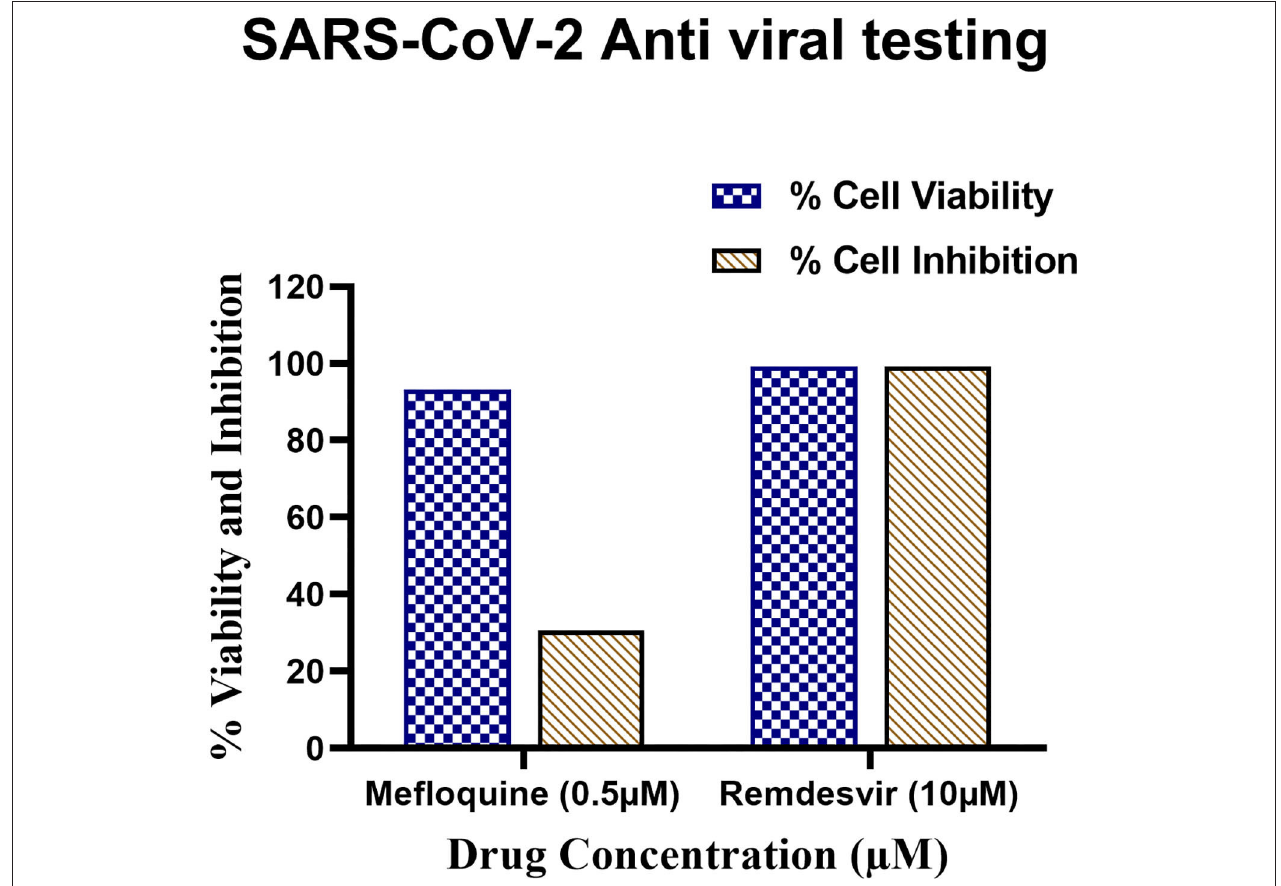
FIGURE 10 | Antiviral testing of Mefloquine against SARS-CoV-2 in VeroE6 cells. (i) The ∼ 10 4 VeroE6 cells were pre-treated with Mefloquine and Remdesivir drug for 30h at 37 ◦ C. Post-incubation, cells were stained with Hoechst 33342 and Sytox orange fluorescent dyes. The drug and control molecule treated cells were counted through stained Hoechst and Sytox image by using MetaXpress software. From raw images, the % average cell viability with control cells were calculated and the bar diagram highlighted in blue colour was plotted. (ii) 1 MOI of SARS-CoV-2 virus infected Vero E6 cells were treated with mefloquine drugs. The cells were fixed, permeabilized, and stained with mAb specific to SARS-CoV-2 nucleocapsid (primary) followed by alexafluor 568-labeled antibody (secondary) and all the cells were stained with Hoechst 33342 stain. The nucleocapsid positive and total nuclei cells were counted from the stained image and the % average cell inhibition with all the controls were calculated and the bar diagram highlighted in brown colour. All these assays were performed in triplicate wells.